Question: Express in one sentence what the figure is showing.
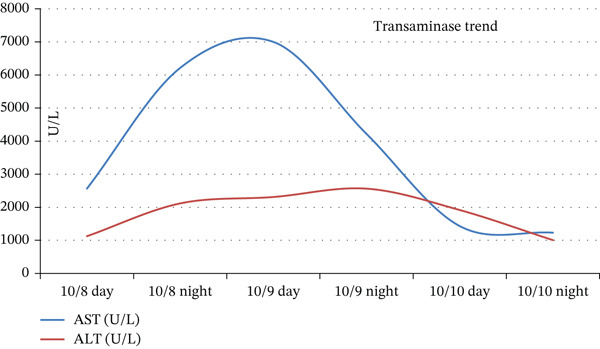
Answer: Trend of serum transaminases during the ICU course.